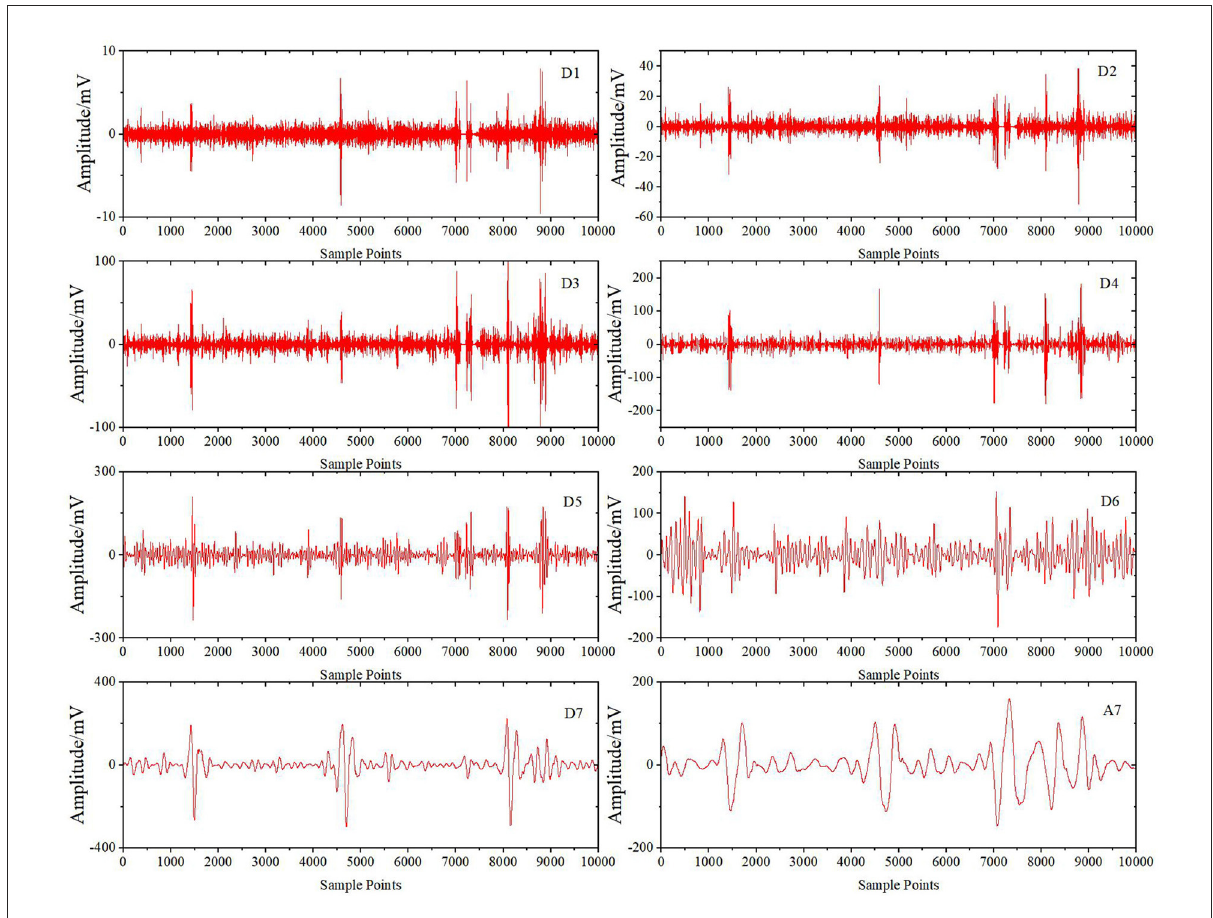
FIGURE6 Wavelet decomposition